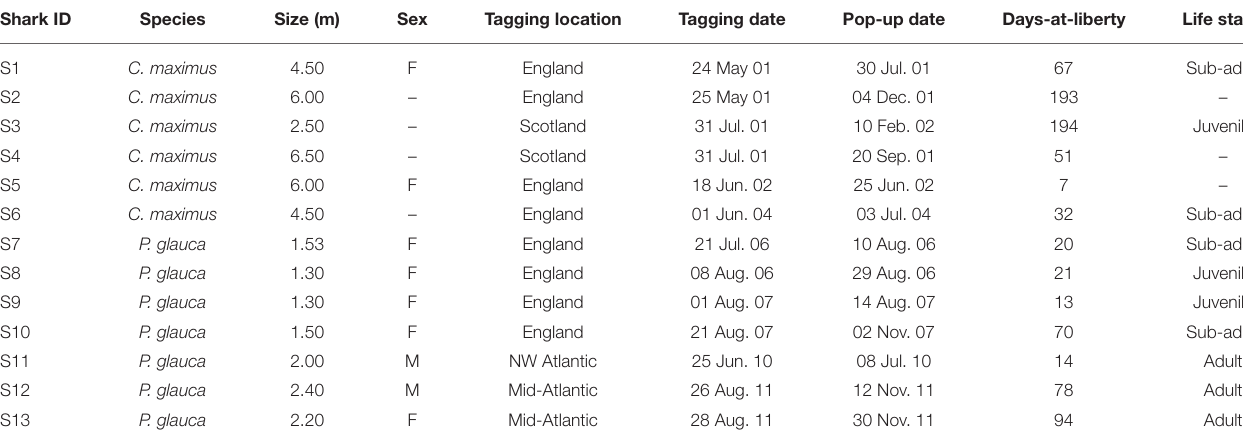
TABLE 1 | Summary data of the six basking and seven blue sharks from which archival tags were recovered. Shark